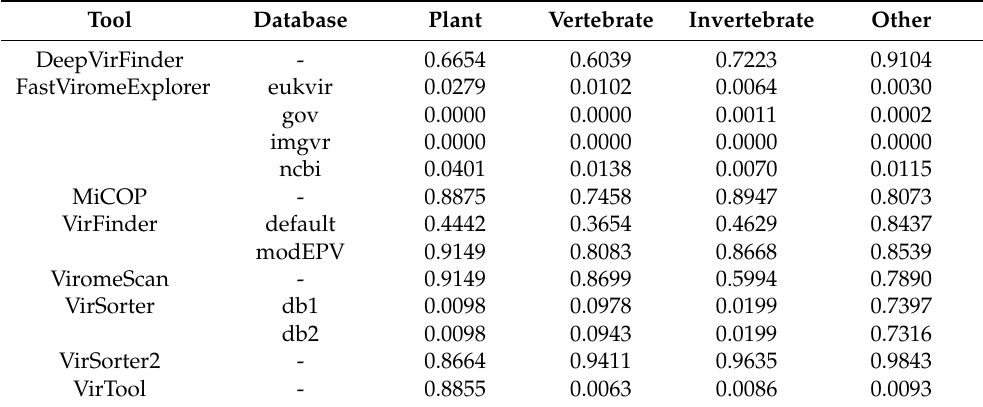
Table 5. Detection sensitivity for nucleotide sequences using virus detection pipelines. Note that the sensitivity of VirTool was assessed using only the sequence mapping portion of the workflow—the VirTool HMM database was assessed as part of the HMM testing later in this manuscript. Tool